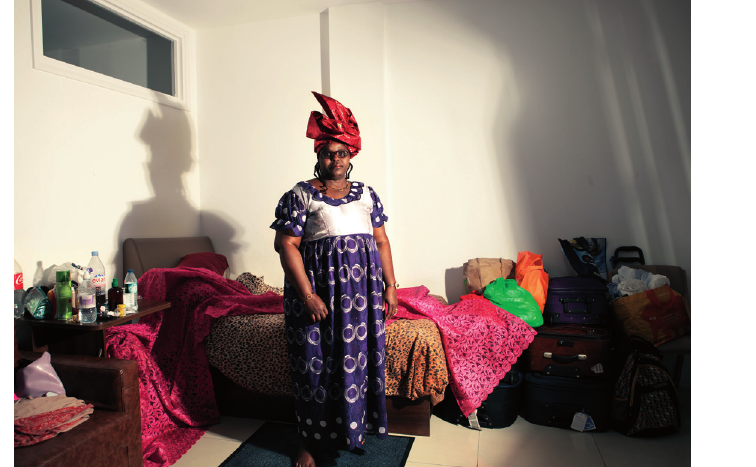
Figure 2: From the series ‘The